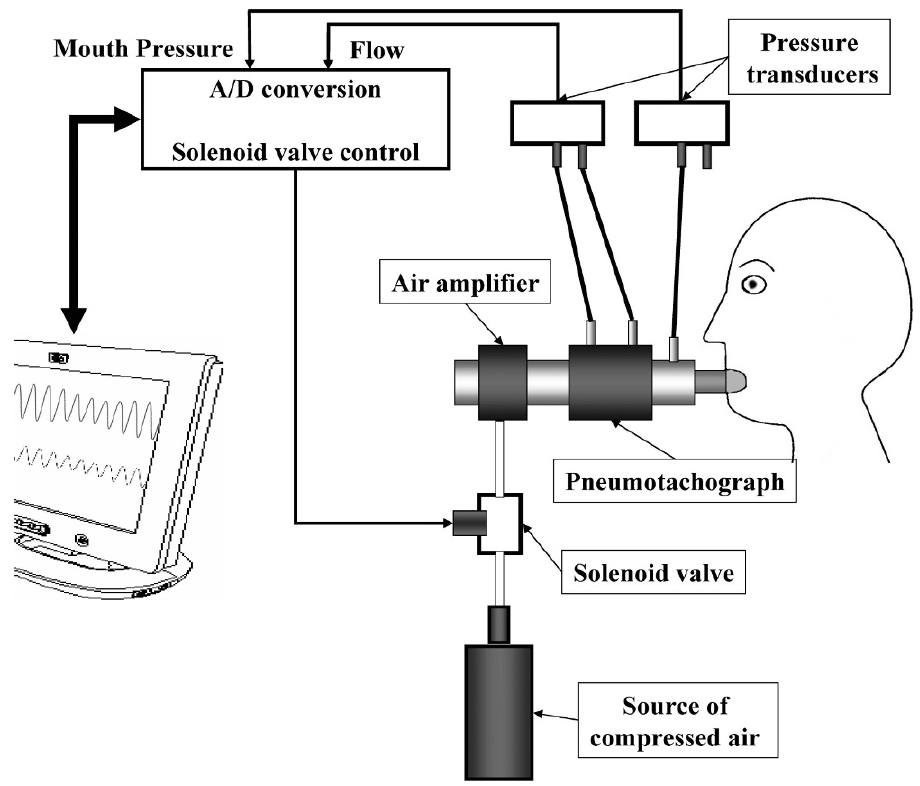
Figure 1 - Schematic representation of the negative expiratory